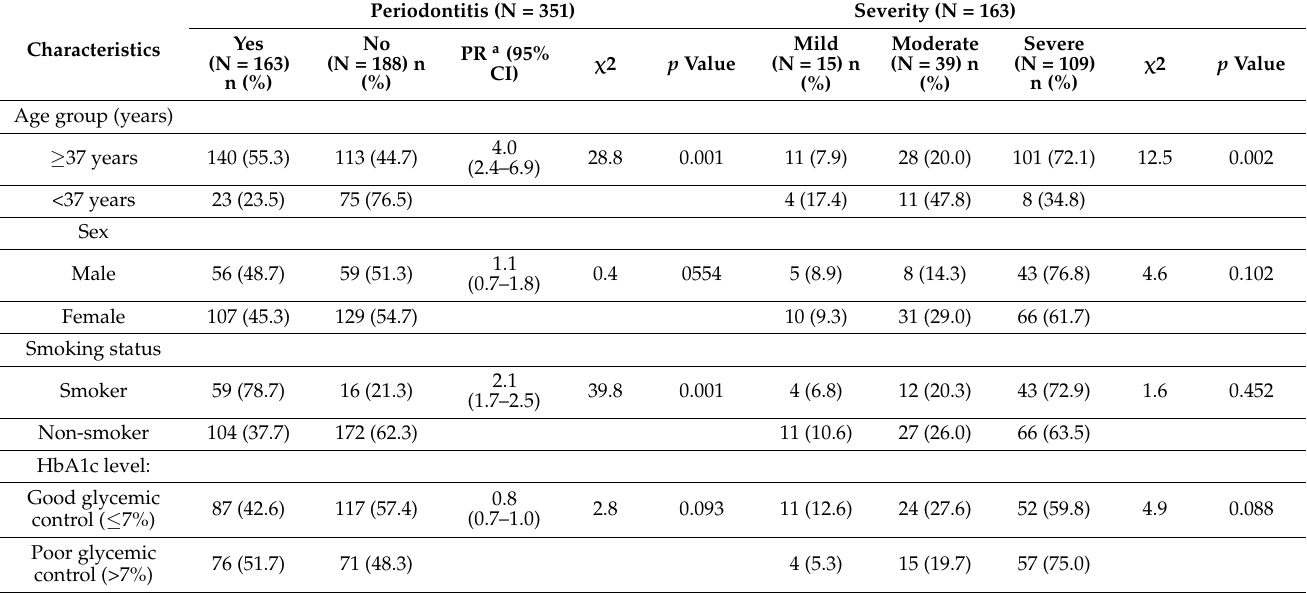
Table 3. The associated factors for periodontitis among type II diabetes mellitus.